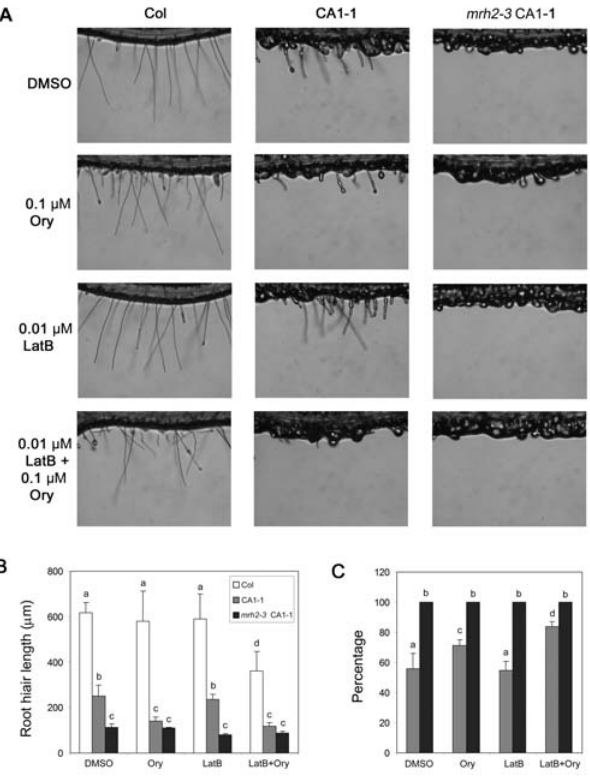
Figure 6. Combination of LatB and Ory treatments in CA1-1 mimics the enhancer phenotype. Seedlings for all of the four genotypes were treated identically as in Figure 7. Representative images are shown in (A), and quantitative analyses of root hairs are shown in (B) and (C). For each genotype/treatment combination, a total of 4 or 5 roots (each with about 20 root hairs on the same root region) were used in the experiment. The average and the SD of the root hair lengths (B) and of the percentage of very short root hairs showing swelling or bulbous shapes (C) are shown. Note that (B) and (C) have the same column labeling, and in (C) there are no very short, swelling or bulbous root hairs. Different letters above the column indicate a statistical significant difference (p ,